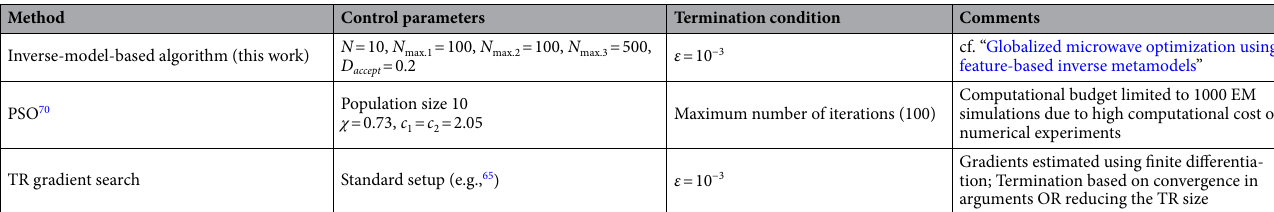
Table 3. Experimental setup: Proposed optimization framework and the benchmark.